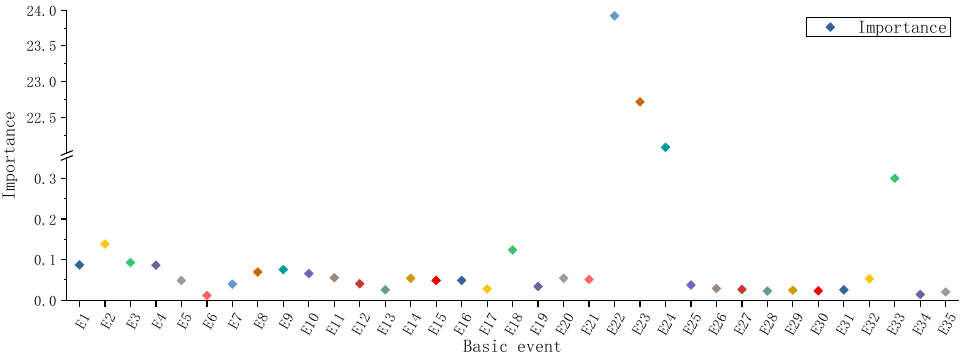
Figure 9. Changes in the importance levels of basic fire events in ship power system fires.